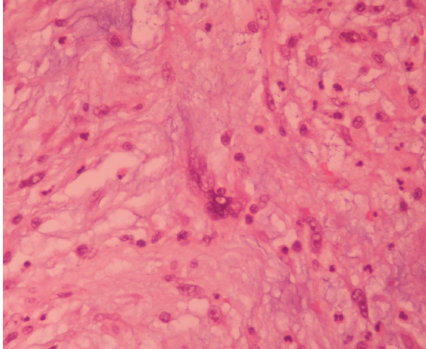
Figure 4: Anaplastic spindle cell neoplasm with prominent myxoid and collagenous stroma with a high degree nuclear pleomorphism. The diagnosis of low grade DDL was made after immunohistochem- ical confirmation. Hematoxylin-eosin stain (H&E) ×